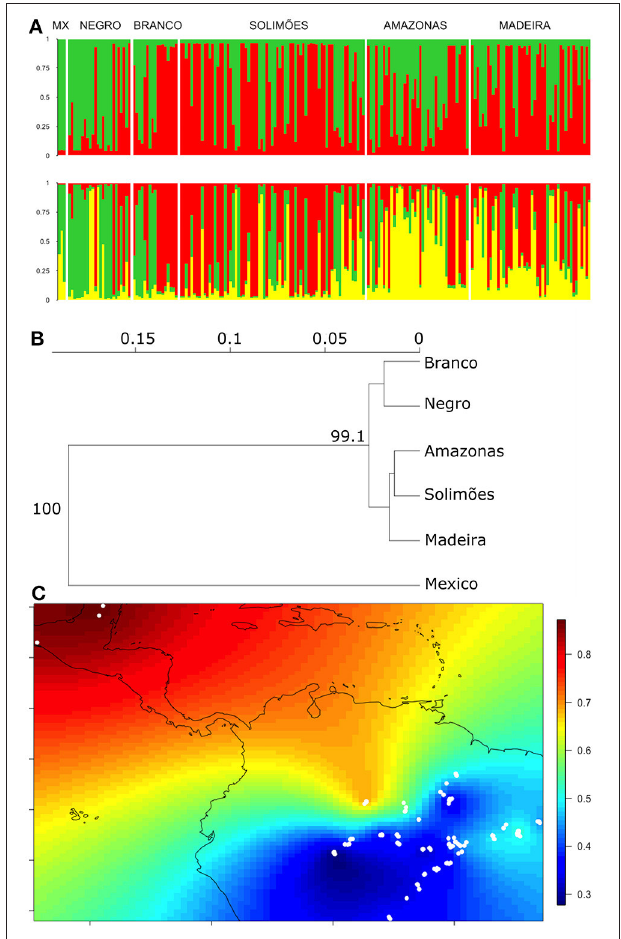
FIGURE 3 | Nuclear genetic differentiation between cultivated C. cujete samples ( N = 200) from Mexico and Brazilian Amazonia using 8 nSSR. Only samples with high cultivated membership ( > 0.6) from Figure 2 were included. (A) Structure analysis based on correlated allele frequency model. Plots show the two likely groupings ( K = 2 and K = 3). The y-axis shows the proportion of assignment to the cluster and each vertical bar represents a single plant. Samples were ordered by their geographical location along the main rivers/country: the Negro, Solimões, and Amazonas Rivers are ordered west to east; the Branco River and Mexico are ordered north to south; the Madeira River is ordered south to north. (B) Neighbor-joining tree of the geographic relationships based on Nei’s genetic distance with 1000 bootstraps supports indicated on the nodes. (C) Spatial interpolation of the Structure clusters (Q) at K = 2 indicated above ( Figure 3A ). The colored bar on the right indicates the probability of assignment to the green cluster ( Figure 3A ) between samples (white dots). Although the admixture between Mexico and Amazonia ( Figure 3A ), genetic similarity is higher between Mexican samples and northwestern Amazonia. Within Amazonia, cultivated C. cujete is genetically homogeneous, except by the differentiation in the Northwest and in the Eastern, which agrees with K = 3 ( Figure 3A